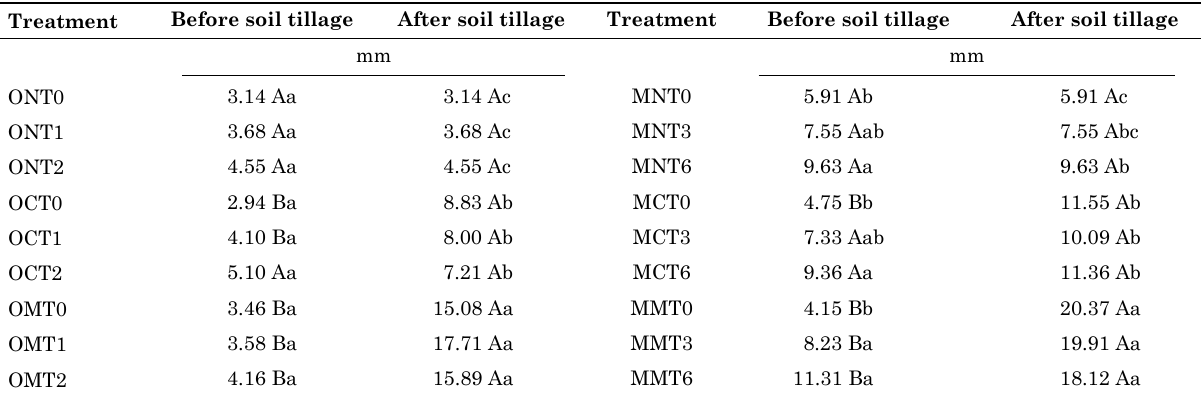
Table 4. Random roughness index in the treatments under diverse rates of oat and maize residue Treatment Before soil tillage After soil tillage Treatment Before soil tillage After soil